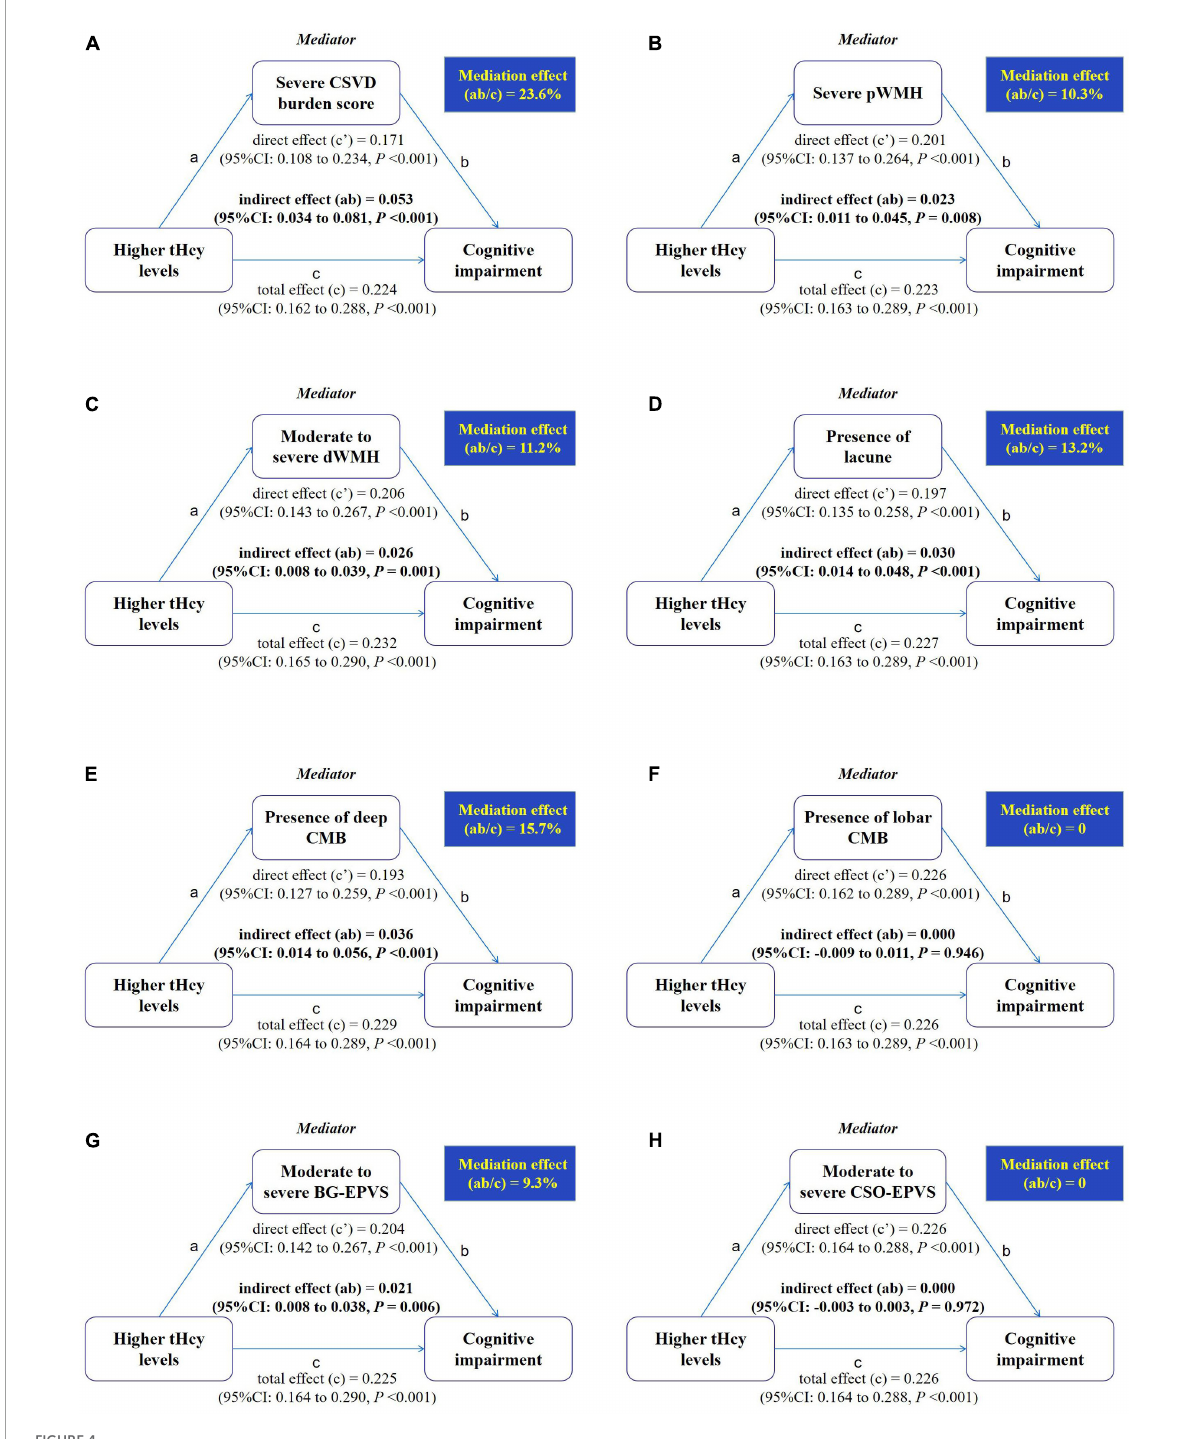
FIGURE4 Mediation by different markers of CSVD in the relation between higher serum tHcy levels and cognitive impairment. Mediation analyses are shown for different markers of CSVD as mediators in the relation between higher serum tHcy levels and cognitive impairment. (A) The mediator is a severe CSVD burden score. (B) The mediator is severe pWMH. (C) The mediator is moderate to severe dWMH. (D) The mediator is presence of lacune. (E) The mediator is presence of deep CMB. (F) The mediator is presence of lobar CMB. (G) The mediator is moderate to severe BG-EPVS. (H) The mediator is moderate to severe CSO-EPVS. The mediation effect is the indirect effect expressed as a percentage of the total effect, that is, the proportion of the relation between the independent and dependent variables attributable to